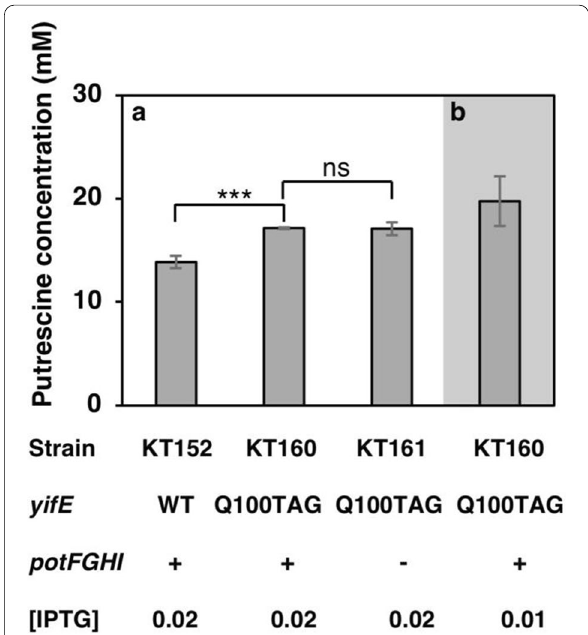
Fig. 8 Effects of the yifE mutant and putrescine transporter PotFGHI on putrescine production. a The putrescine concentration in the supernatant of the culture media of strains KT152, KT160, and KT161 grown in terrific broth supplemented with 100 μg/mL of ampicillin for 48 h. When the OD 600 reached 0.4, 0.02 mM IPTG was added. b The putrescine concentration in the supernatant of the culture media of strains KT160 grown in terrific broth supplemented with 100 μg/mL of ampicillin. When the OD 600 reached 0.4, 0.01 mM IPTG was added. * p < 0.001; ns, not significantly different. yifE : WT, yifE wt ; Q100TAG, yifE Q100TAG gene. potFGHI : , presence of potFGHI + operon; -, absence of potFGHI operon. [IPTG]: 0.01 and 0.02 is the optimum concentration of IPTG in terms of mM. Data shown are averages standard deviations, and culture experiments were ± performed in